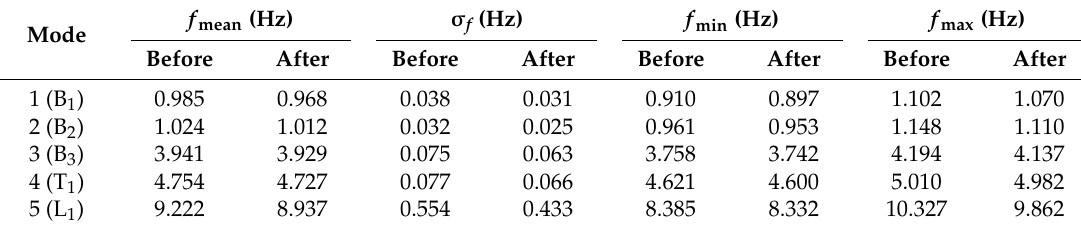
Table 2. Statistics of the modal frequencies identified before and after the seismic event of 21/06/2013.